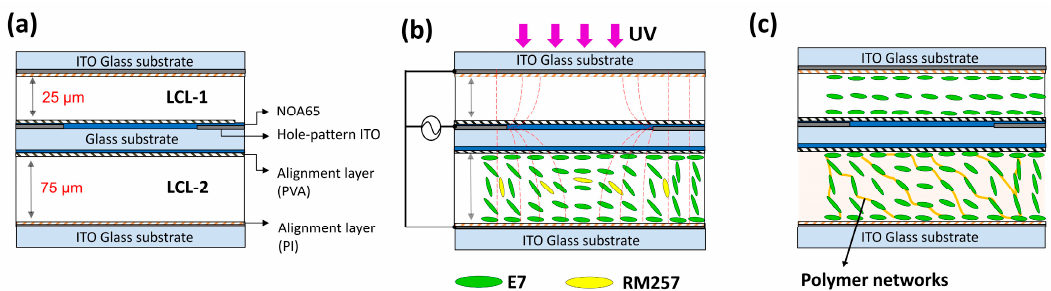
Figure 2. Scheme of the major fabrication process of the TLCL LC lens: ( a ) Structure of the TLCL lens; ( b ) Processing of the LC mixture filled in the LCL-2 layer via UV exposure and applying voltages to fix the LC molecular orientation via RM257 polymer networks; ( c ) Filling E7 LCs into the 25 μ m gap (LCL-1) to achieve LC lens fabrication.